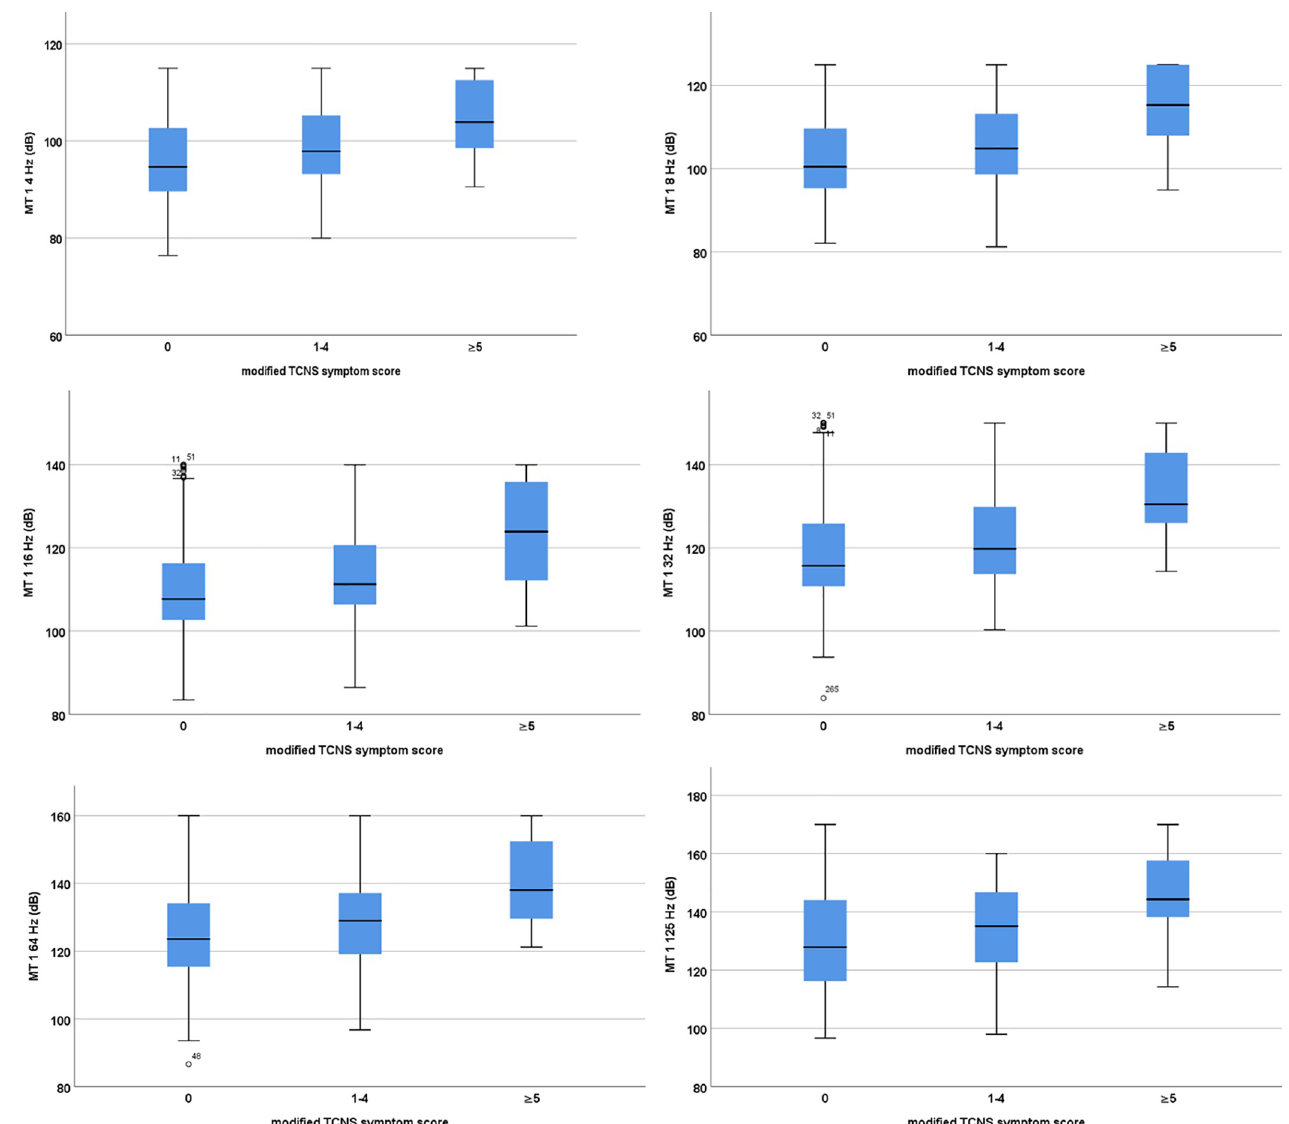
Fig 4. Vibration perception thresholds on the metatarsal head 1 in T1DM patients according to TCNS symptom score.